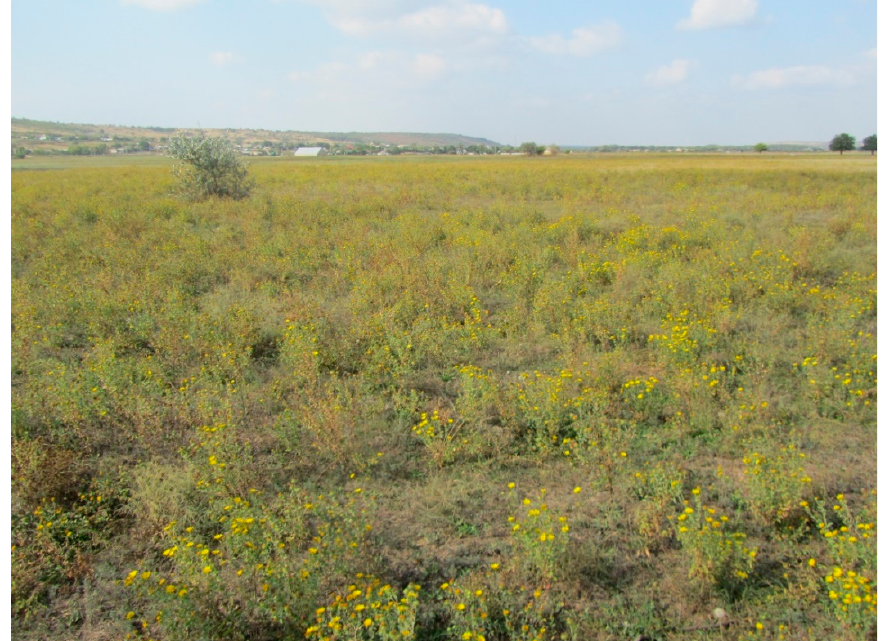
Figure 9. The reclaimed area of the floodplain, which was plowed in the past and is currently used as a pasture (surroundings of Severynivka village). An invasion of Grindelia squarrosa ( Artemisietum santonicae association) is in the foreground.